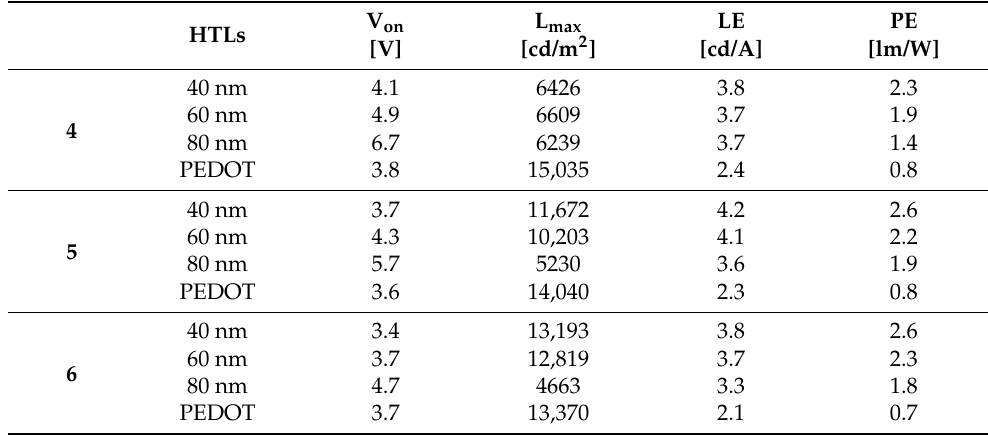
Table 1. OLED characteristics of the devices with the configuration: ITO/HTL of 4 – 6 /Alq 3 /LiF/Al having different thicknesses of